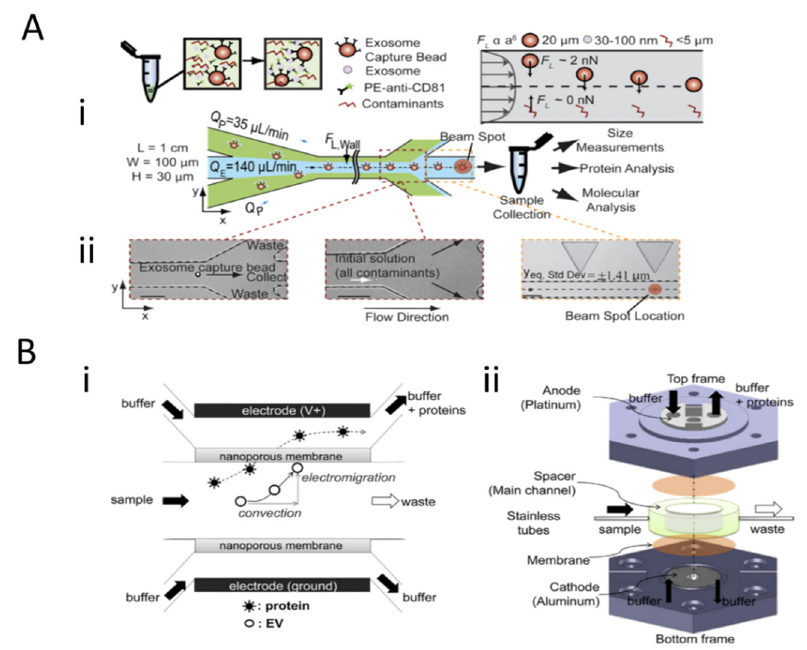
Figure 3. Size-based and combination techniques for the isolation of exosomes. ( A ) Workflow for the rapid inertial solution exchange for the enrichment and flow cytometric detection of microvesicles using exosome capture beads and microfluidic flow system. ( B ) Schematic of extracellular vesicle isolation with electrophoretic migration techniques using a nanoporous membrane and Faradaic reactions between device electrodes. ( A ) and ( B ) parts of figure were adapted with permission under the Copyright Clearance Center.